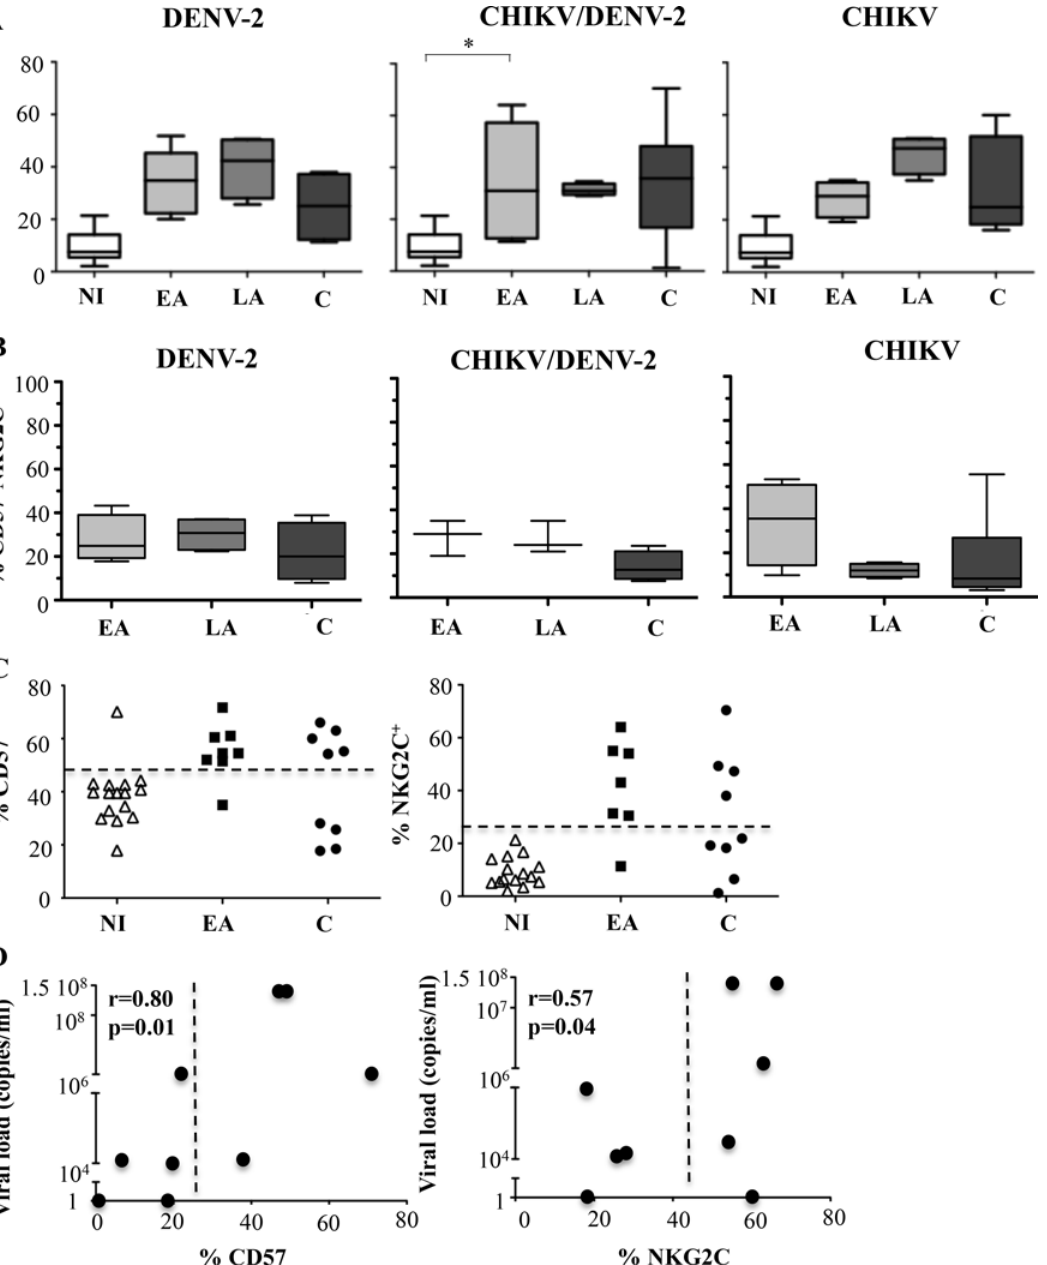
Fig 2. Persistence of NKG2C + CD57 + NK cells in CHIKV-infected patients with high viral loads. Results are grouped according to 1) type of infection: DENV-2, CHIKV or co-infected by CHIKV and DENV-2 (CHIKV/DENV-2), and non-infected Gabonese healthy controls (NI) and 2) date of sample collection after onset of symptoms: early acute (EA; day (D)0-D3), late acute (LA; D12-D15) and convalescent (C; D > 30). (A) Frequency of NKG2C + cells within CD3 - CD56 + NK cells amongst all patient groups (B) Frequency of CD57 + NK cells within NKG2C + or NKG2C - NK cell-subsets from CHIKV-, DENV-2- and co-infected patients analyzed at Day 30 post-symptoms. (C) Scatter plot representation of CD57 + and NKG2C + NK cell frequencies collected in CHIKV- infected patients. Dotted vertical lines represent the baseline levels. (D) Correlation between the set point of the viral load quantified during the early acute CHIKV infection and CD57 + or NKG2C + NK cells analyzed at Day 30 post-symptoms. Dotted horizontal lines represent baseline levels. * p < 0.05, ** p < 0.001.